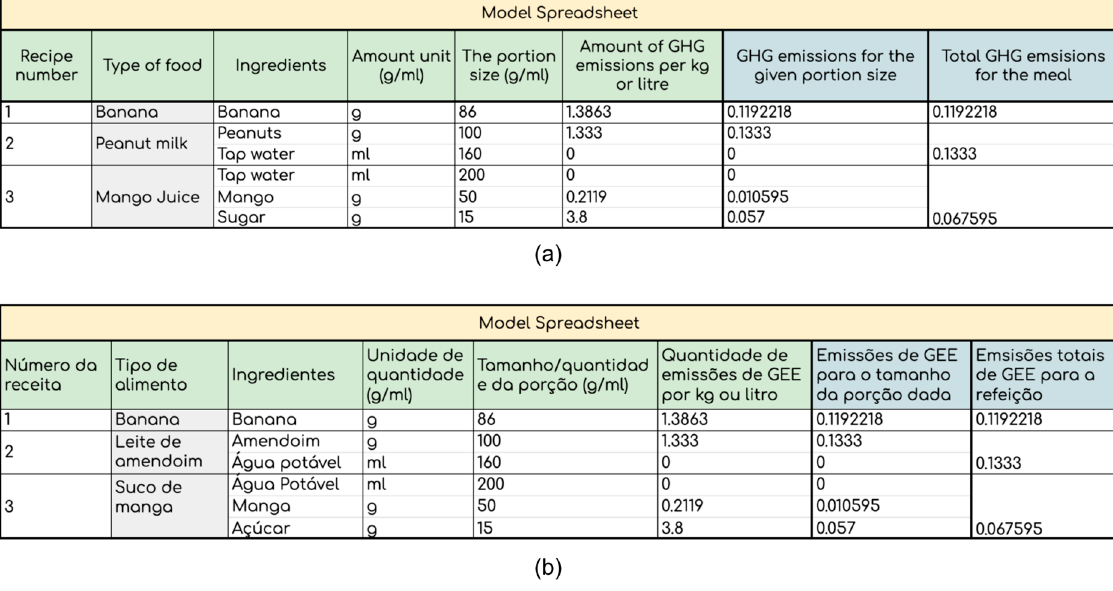
Figure 8. Educational calculator. Figure shows: ( a ) the calculator in Google spreadsheet in English, with the GHGE calculation example for banana, peanut milk, and creamy pudding; ( b ) the same spreadsheet in Portuguese.